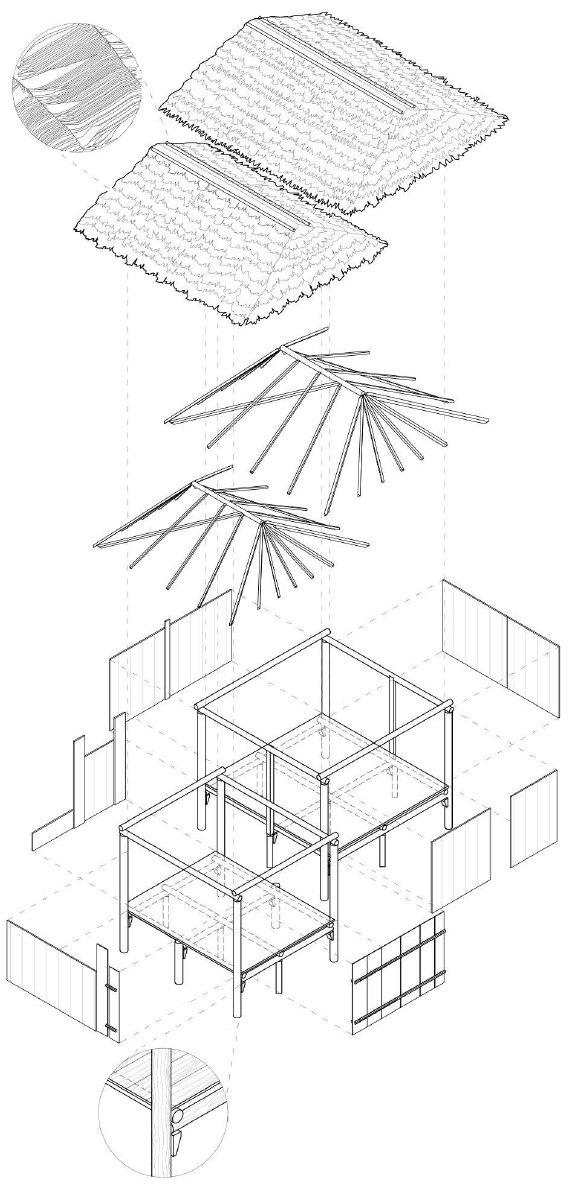
Figure 8. Isometric exploded view of Maria Yoilen’s